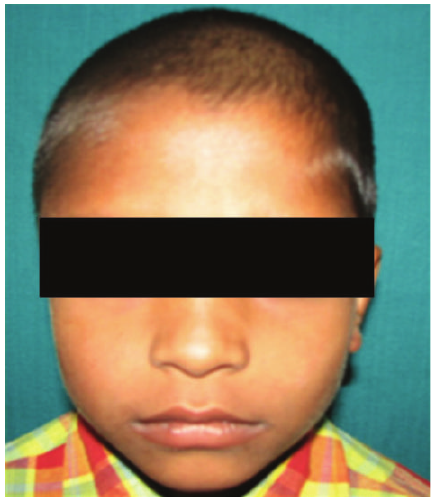
Figure 4: Two weeks postoperative picture of the